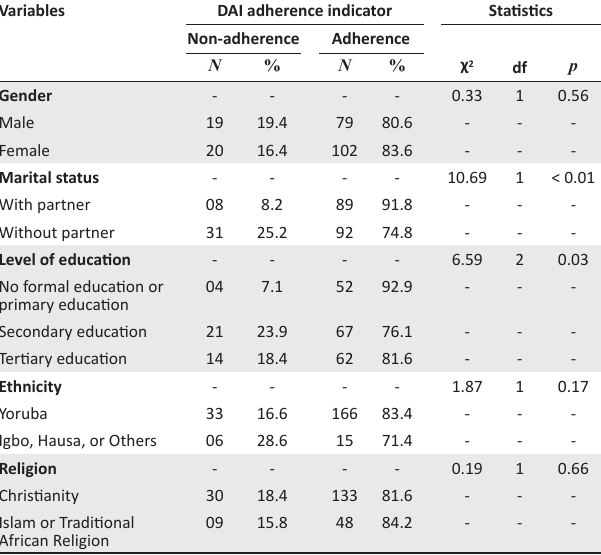
TABLE 2: Association between sociodemographic variables and